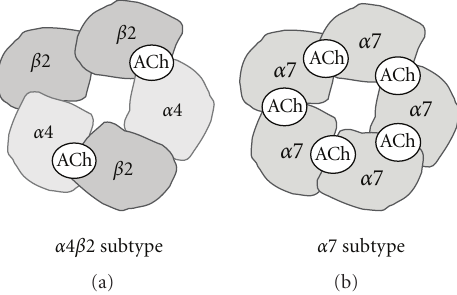
Figure 1: Structures of α 4 β 2 nAChR (a) and α 7 nAChR